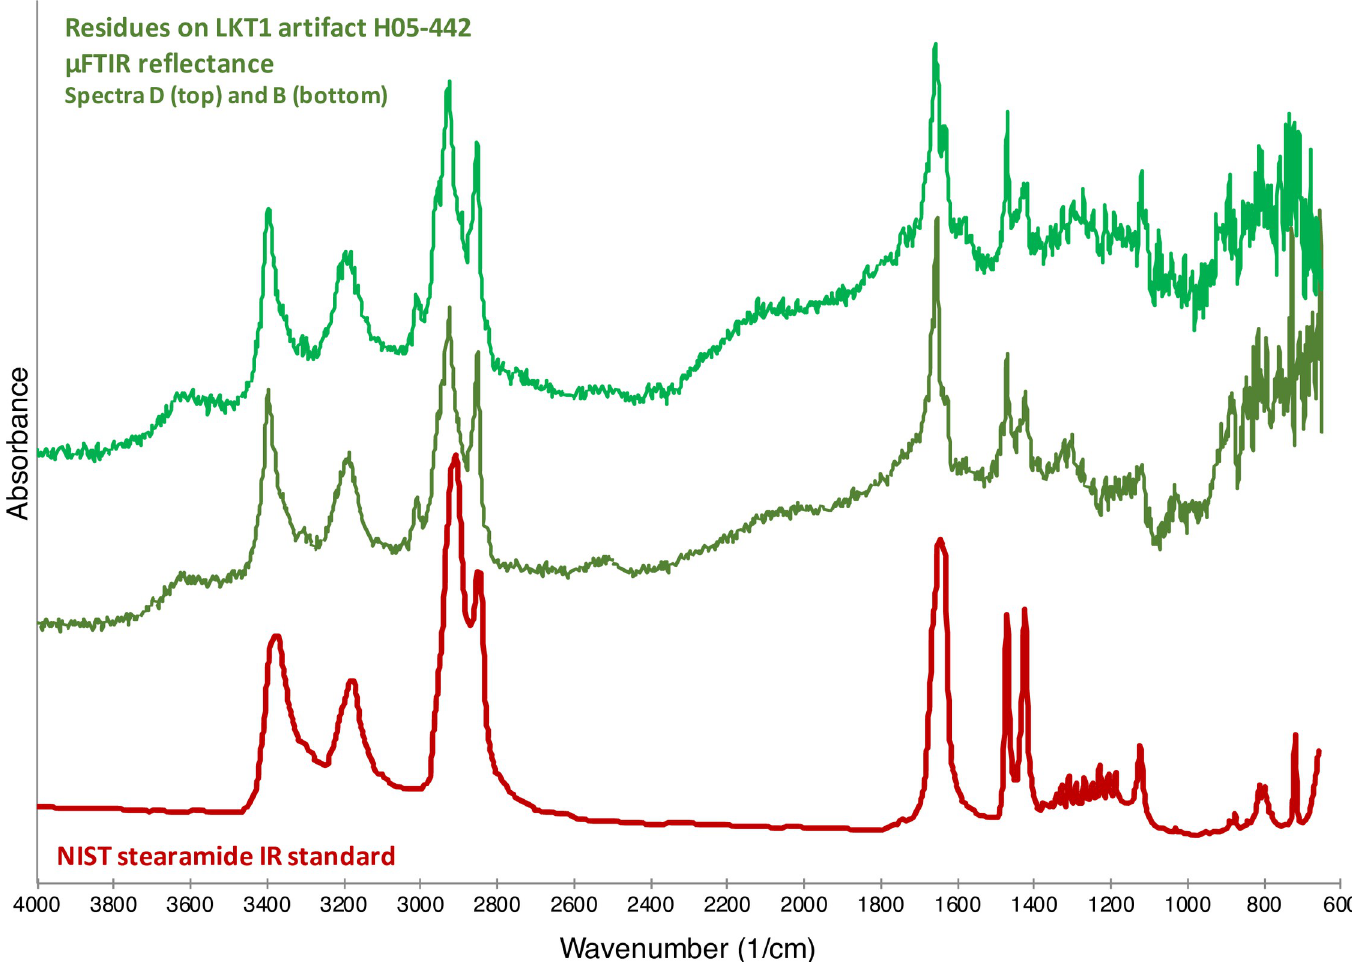
Fig 7. Artifact residues vs stearamide. Comparison between LKT1 artifact H05-442 micro-residues μ FTIR reflectance spectra (green) and the spectrum for stearamide from the NIST FTIR library (red). These spectra have been vertically offset for clarity.